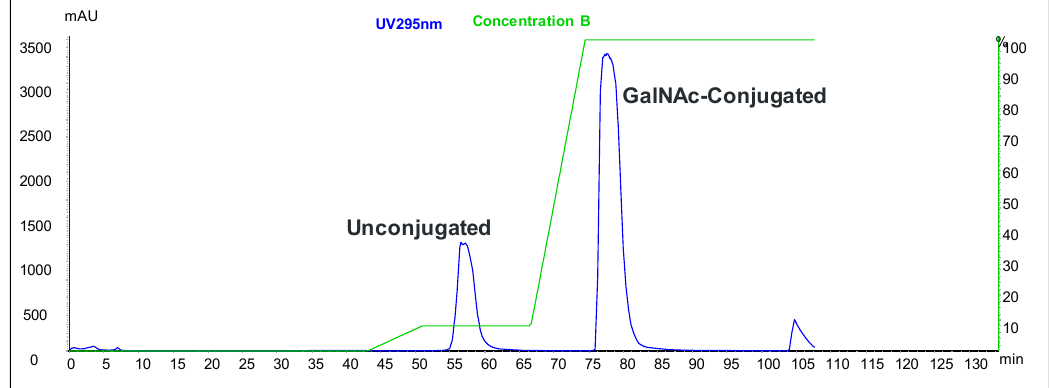
Figure 5. RP-HPLC purification of crude GalNAc-conjugated oligonucleotide with a step gradient. Mobile Phase A is 200 mM NaOAc in 20% MeOH; Mobile Phase B is 200 mM NaOAc in 60% MeOH.